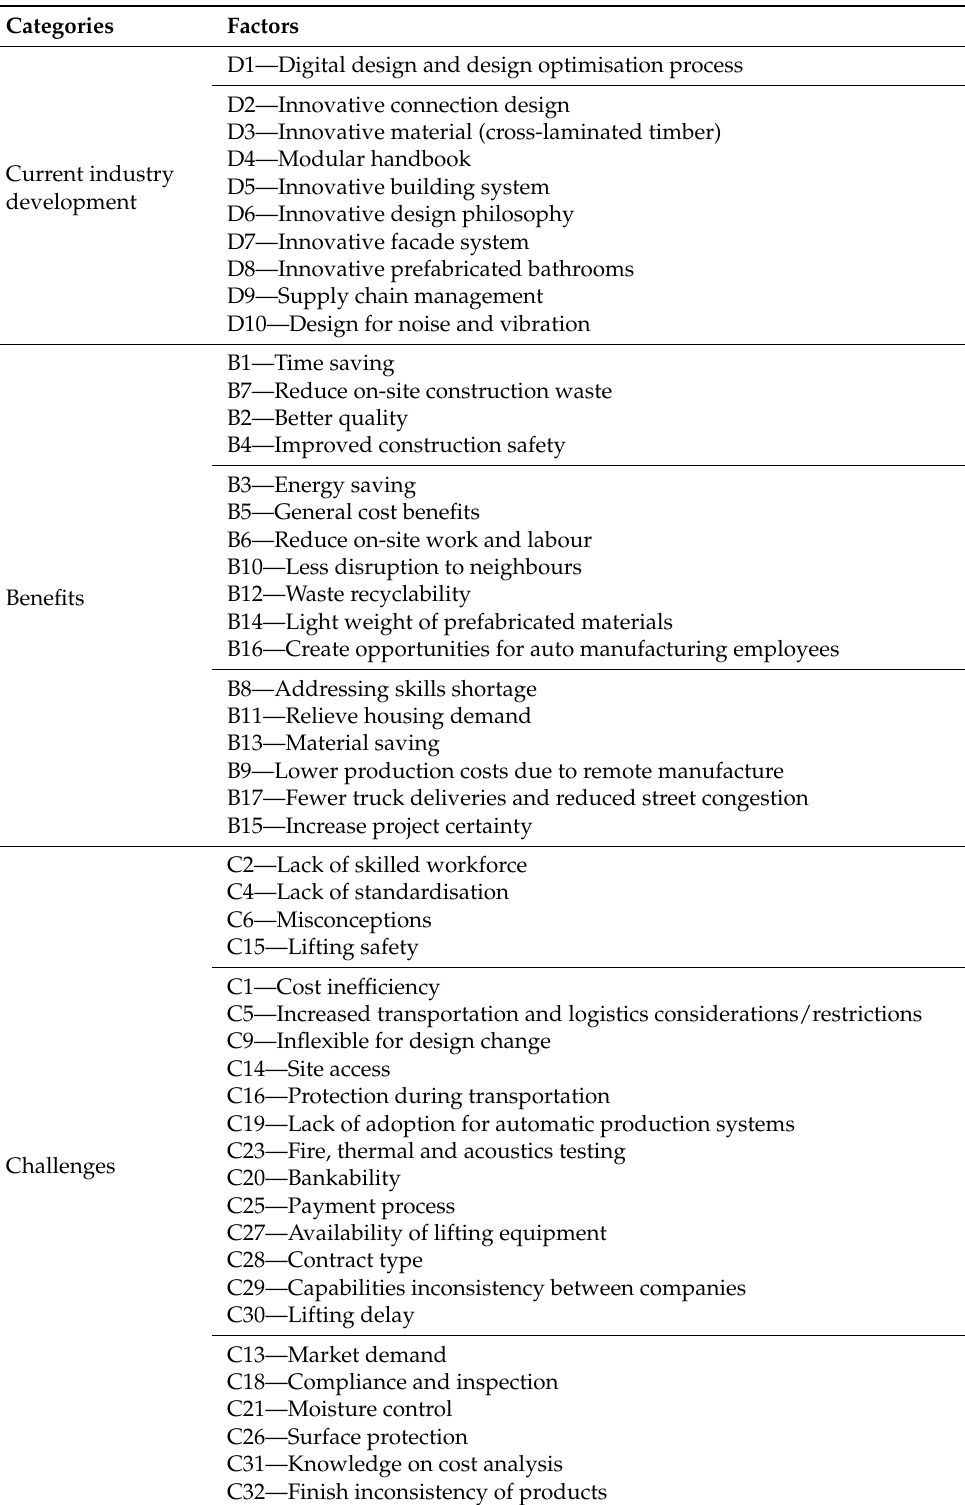
Table 4. Interview factors